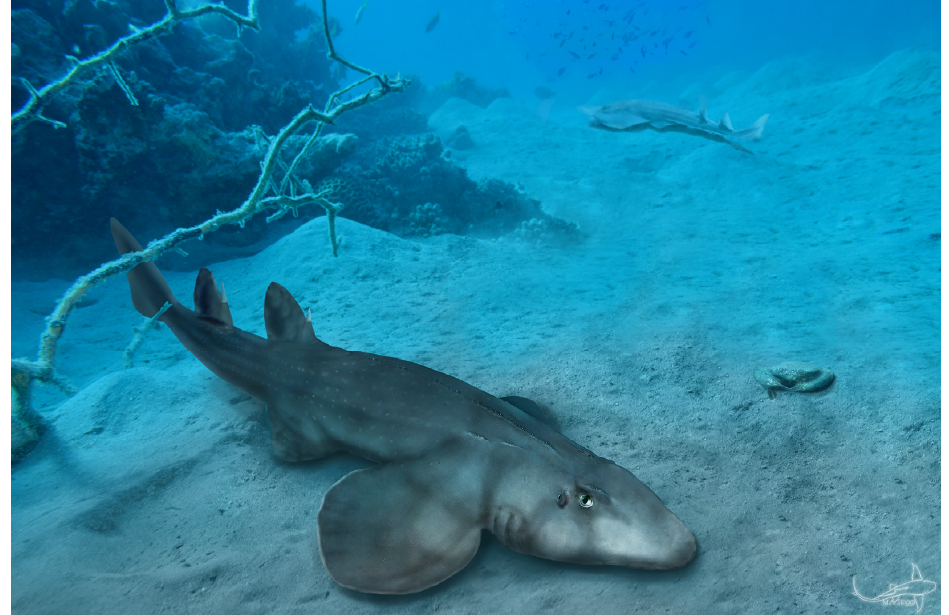
Figure 11. Environmental reconstruction of the Tithonian (Late Jurassic) Solnhofen Archipelago, showing Protospinax annectans in association with the Late Jurassic ray Asterodermus platypterus